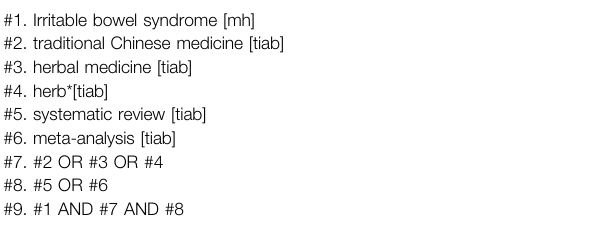
TABLE 1 | Search strategy used in